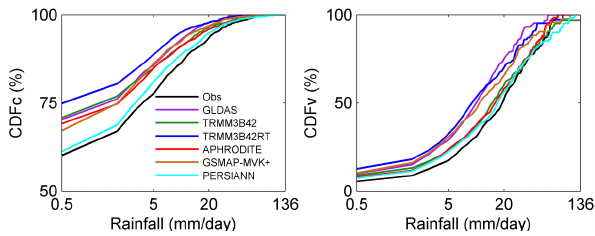
Figure 7. Probability distributions of the six precipitation products by occurrence (CDFc) and volume